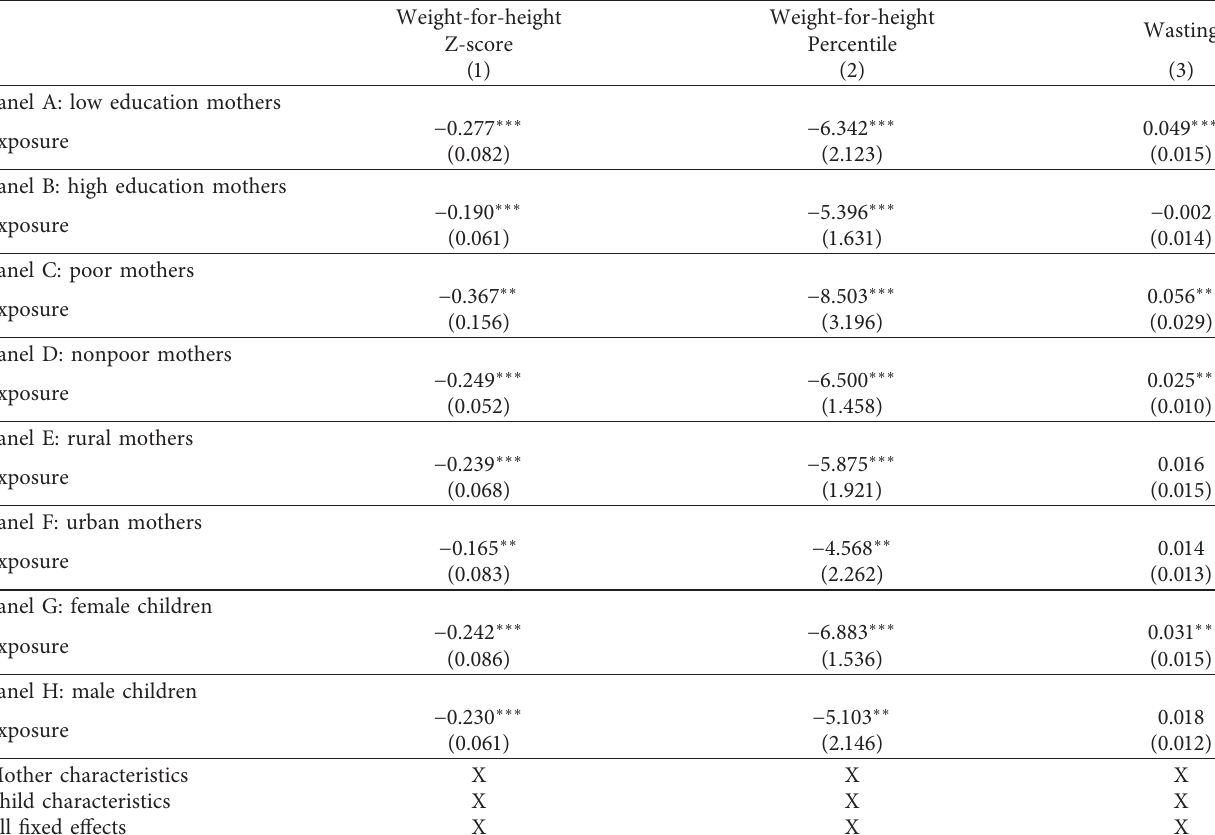
Table 8: Exposure to armed conflict on child weight-for-height heterogeneity. Weight-for-height